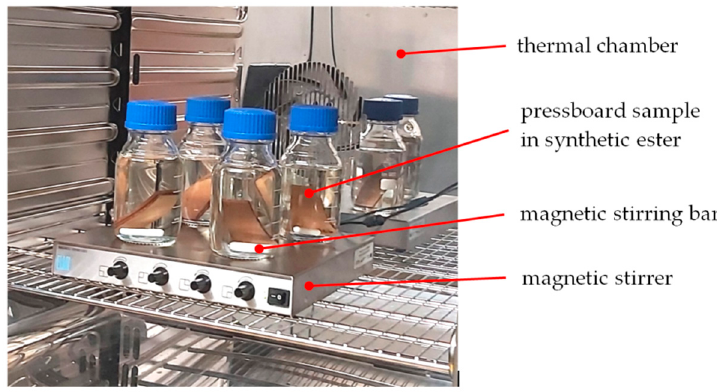
Figure 3. Drying procedure; WCE—water content in ester; WCP—water content in pressboard.